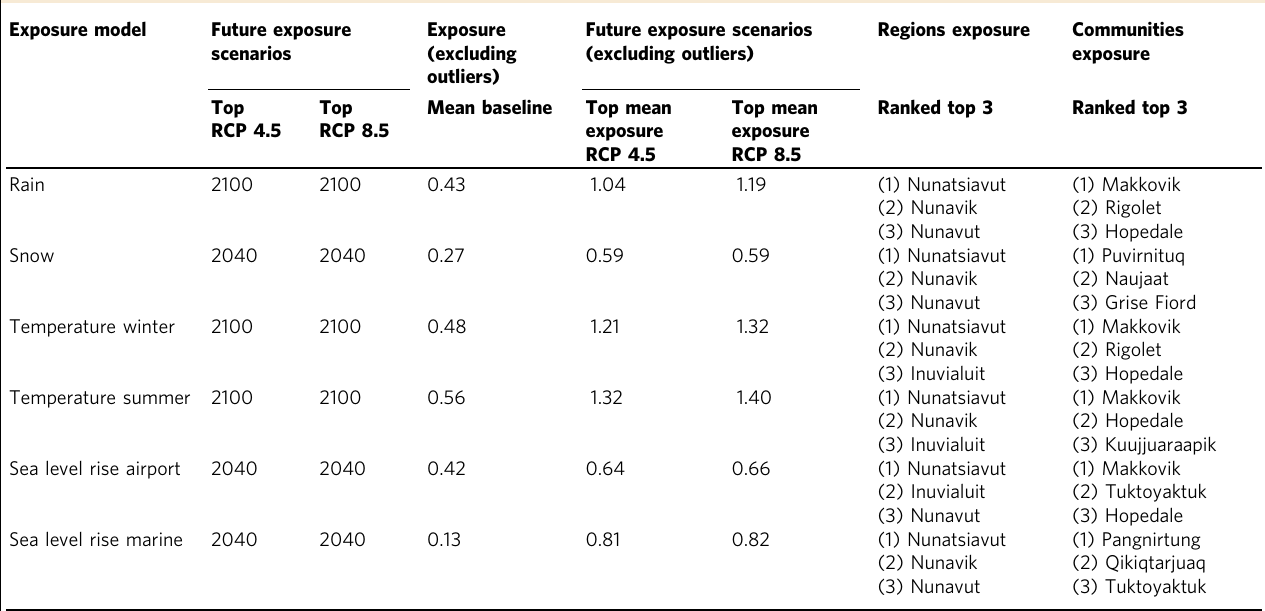
Table 1 Highest projected exposure results for all models, scenarios and top 3 regions and communities Exposure